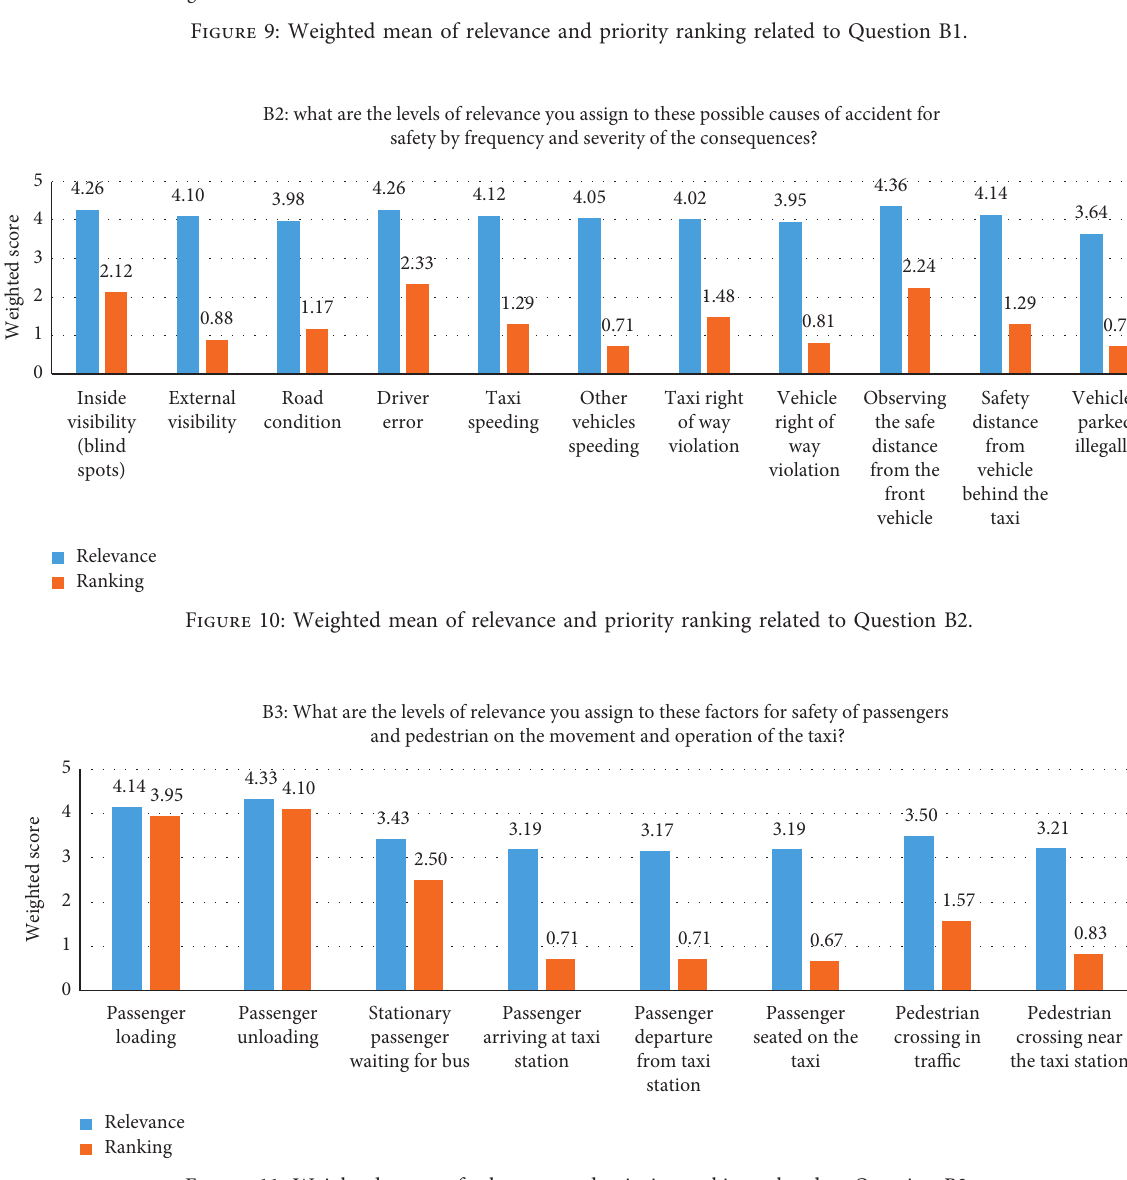
Figure 11: Weighted mean of relevance and priority ranking related to Question